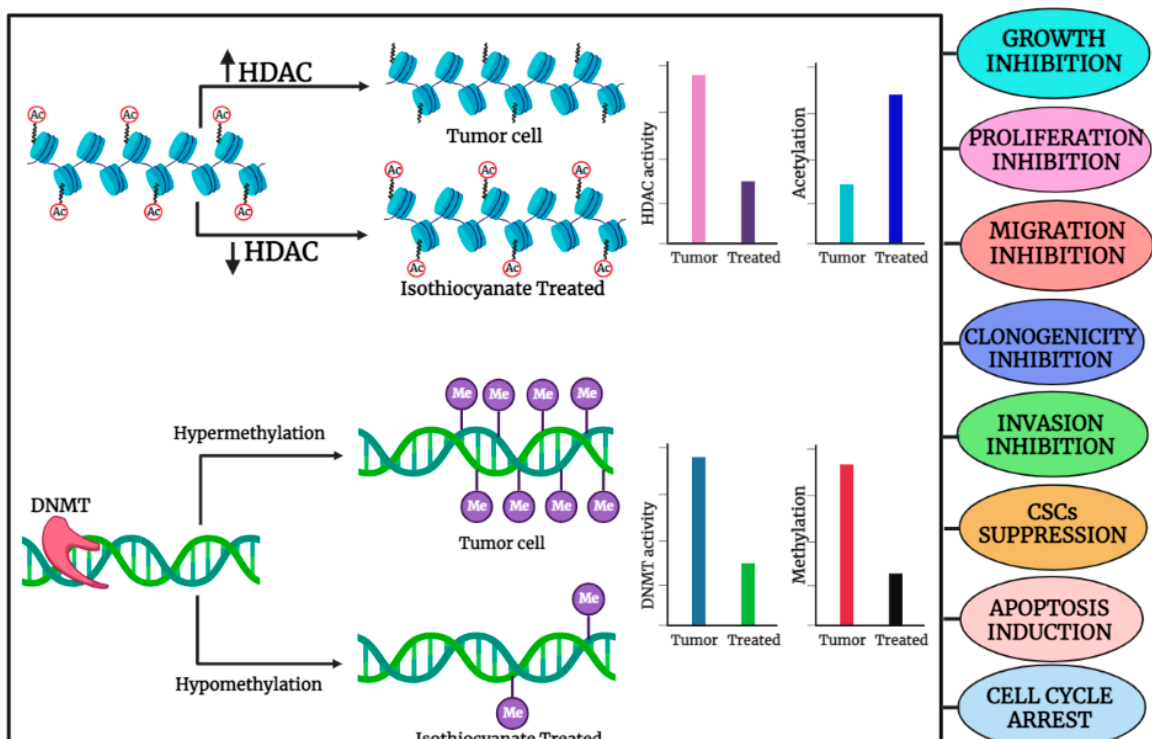
Figure 1. General illustration depicting the role of organo-sulfur compounds in the regulation of HDAC and HDAC activities and their impact on methylation and acetylation, respectively, in cancer cell. The image was created in online software, Biorender.